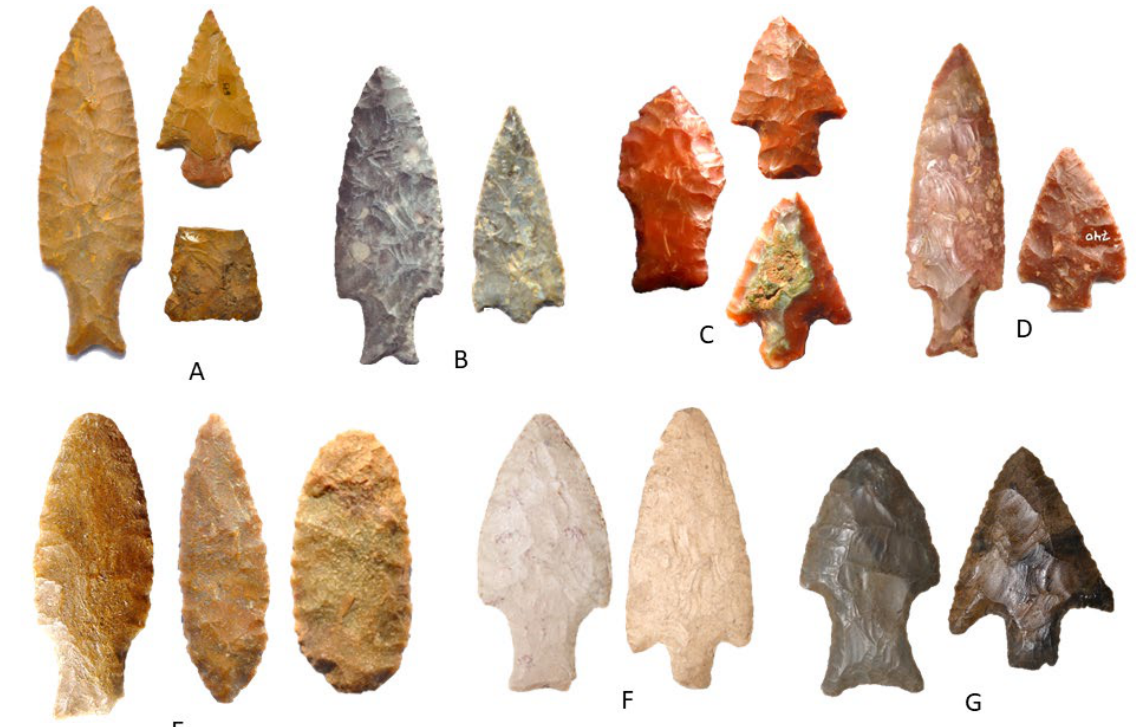
Figure 5. Fell points (left of each group) and Holocene bifaces from southern Brazil. The non-FPs artefacts grouped in A, B, D, and E are curated at Museu ao Ar Livre Princesa Isabel de Orleans, State of Santa Catarina. Group C: the two red cherts points (“Umbú” type) were recovered at the Chapecó county and curated at the Centro de Memória do Oeste de Santa Catarina (CEOM/Unochapecó). One of them preserves the cortex of the tabular node from which it was manufactured (CEOM/Unochapecó collection, Santa Catarina State). F and G: National Museum collection, Universidad Federal do Rio de Janeiro (courtesy of Mercedes Okumura). The groups of pieces are not to scale.